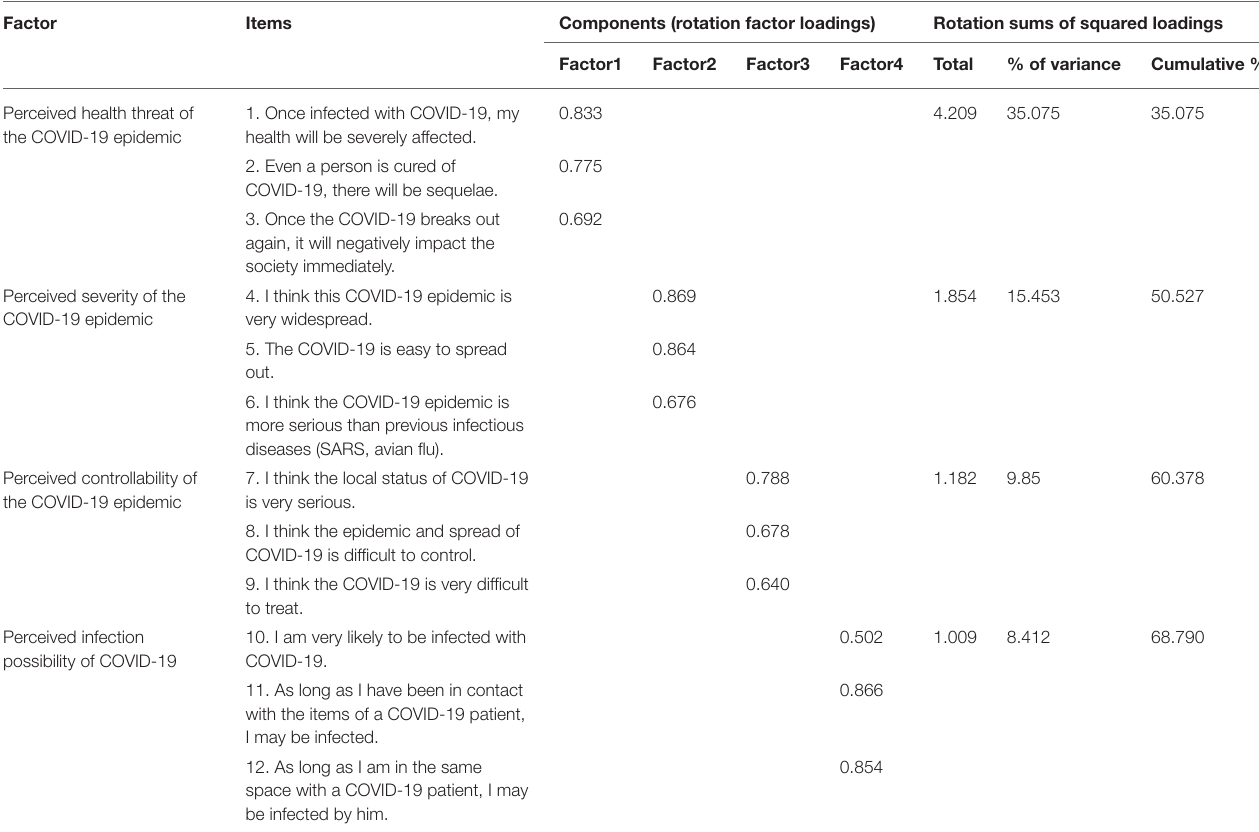
TABLE 1 | Factor analysis for the risk perception of coronavirus disease 2019 (COVID-19).